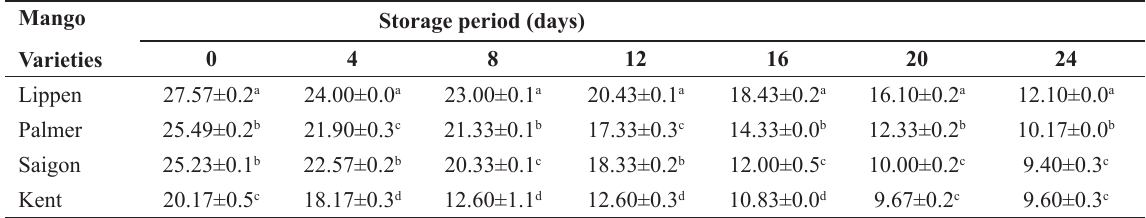
Table 3: Ascorbic acid contents (mg/100 ml) of juice produced from four mango varieties during storage. Mango Varieties